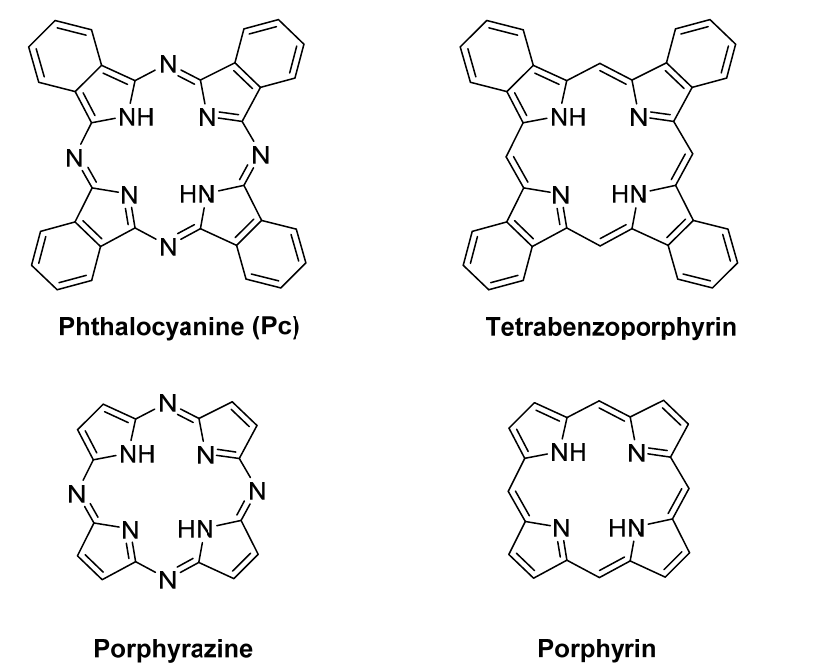
Figure 1. Chemical structures of tetrapyrrolic macrocycles: phthalocyanine, tetrabenzoporphyrin, porphyrazine, and porphyrin core.